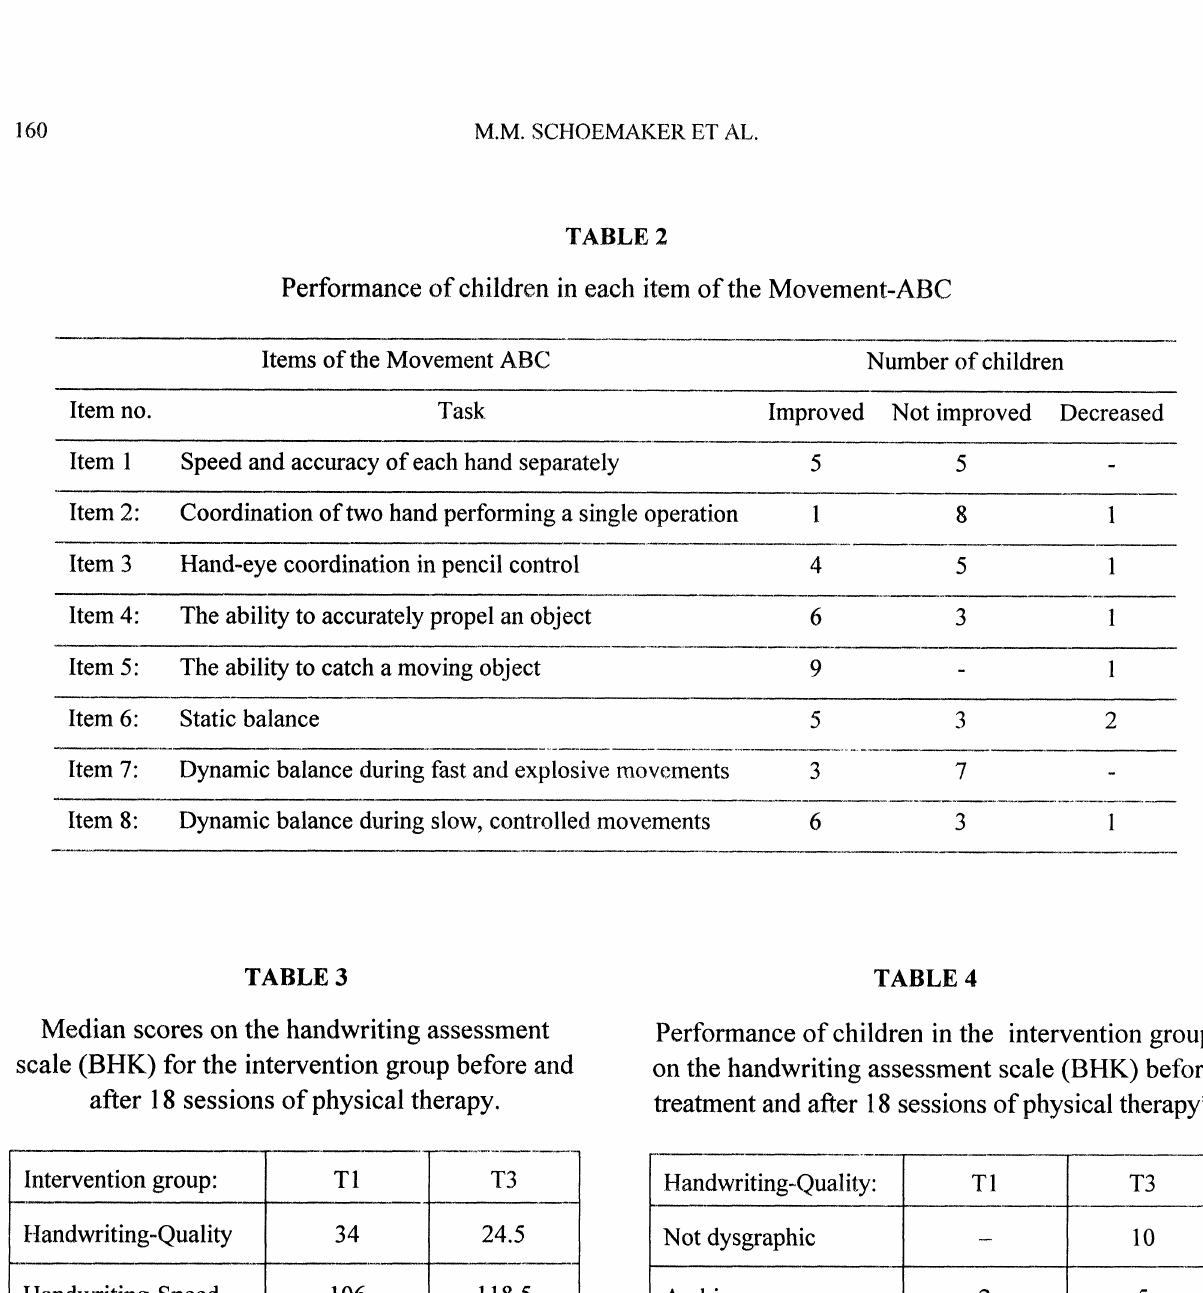
Median scores on the handwriting assessment scale (BHK) for the intervention group before and after 18 sessions of physical therapy.